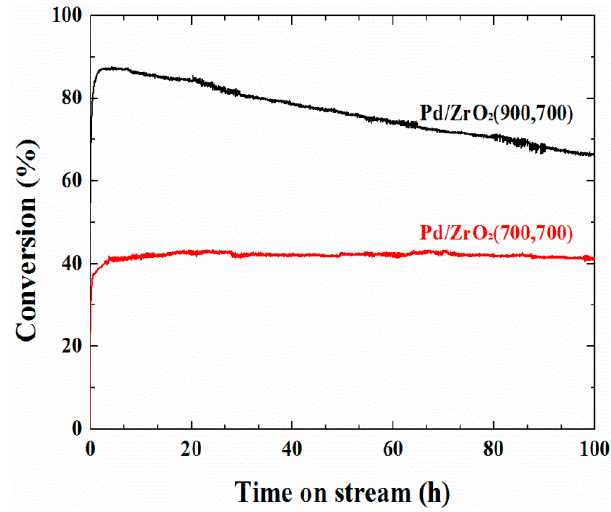
Figure 8. The long-term stability of the Pd/ZrO 2 (900,700) and Pd/ZrO 2 (700,700) catalysts at 450 °C under the wet conditions. The reaction was performed under a constant reactant composition of 10% H 2 O/0.1% CH 4 /3.15% O 2 /N 2 balance with a total flow rate of 400 cm 3 /min (GHSV = 240000 cm 3 g cat − 1 h − 1 ).